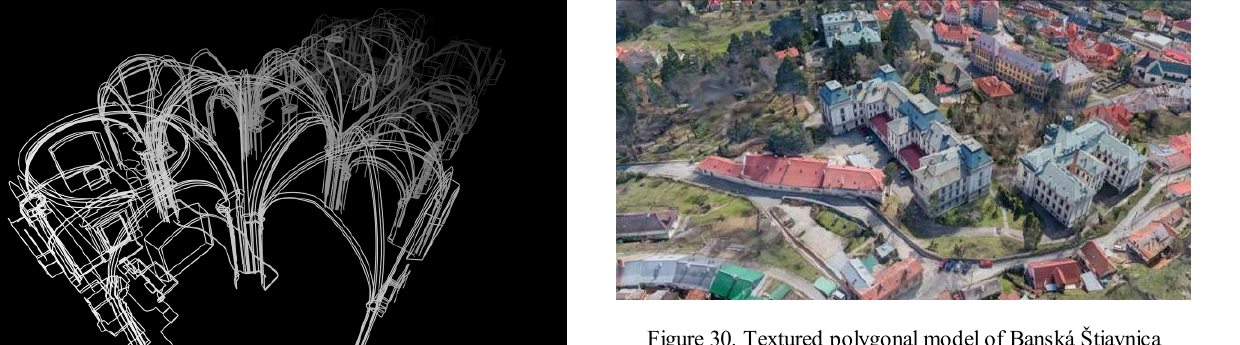
Figure 30. Textured polygonal model of Banská